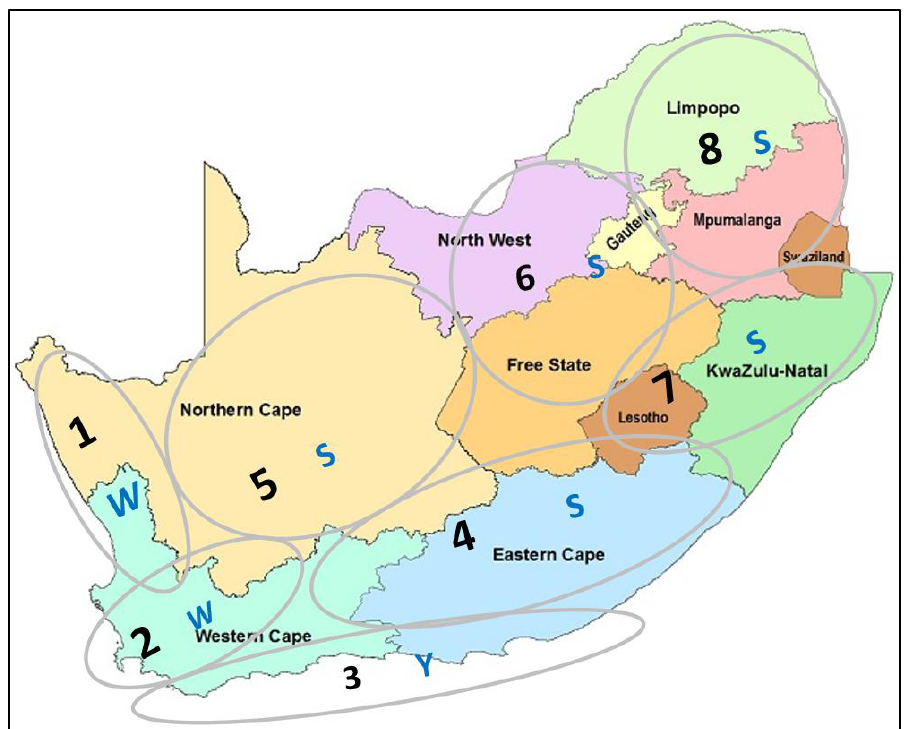
Figure 3. 8 Rainfall Regimes of South Africa. W= Winter Maximum Rainfall, Y= All Year Rainfall, S= Summer Maximum Rainfall. The numbers 1 to 8 represent the 8 climatic regions of SA [28].